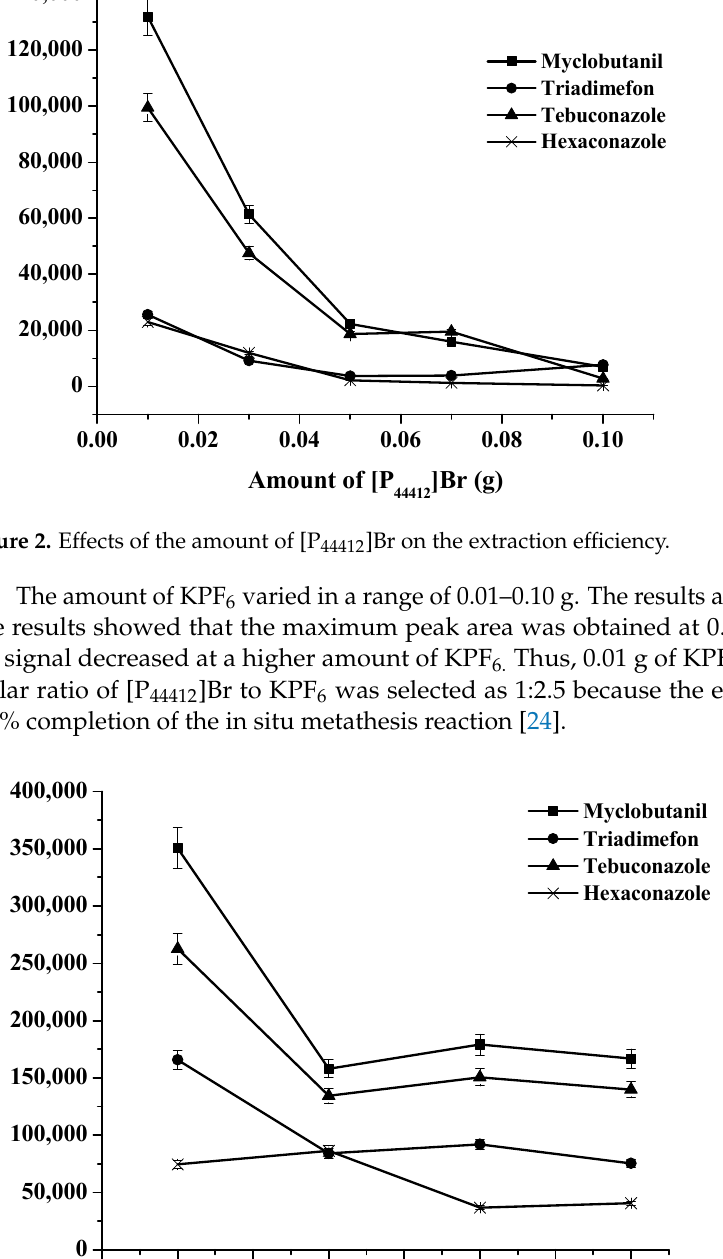
Figure 3. Effects of the amount of KPF 6 on the extraction efficiency.